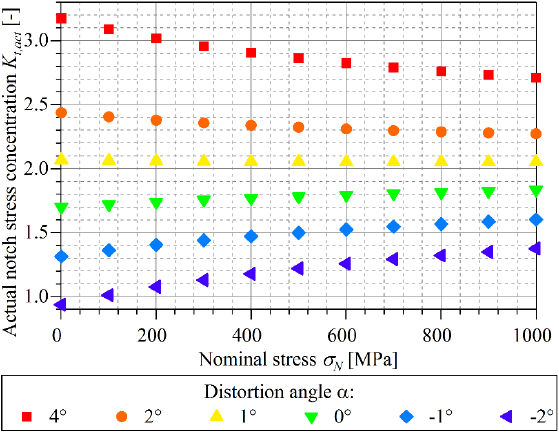
Figure 14. Actual notch stress concentration K t,act with respect to nominal stress and angular distortion.